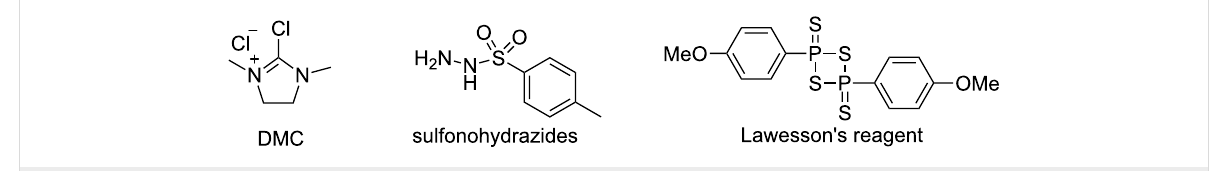
Figure 4: Selective anomeric activating agents providing donors for direct activation of the anomeric